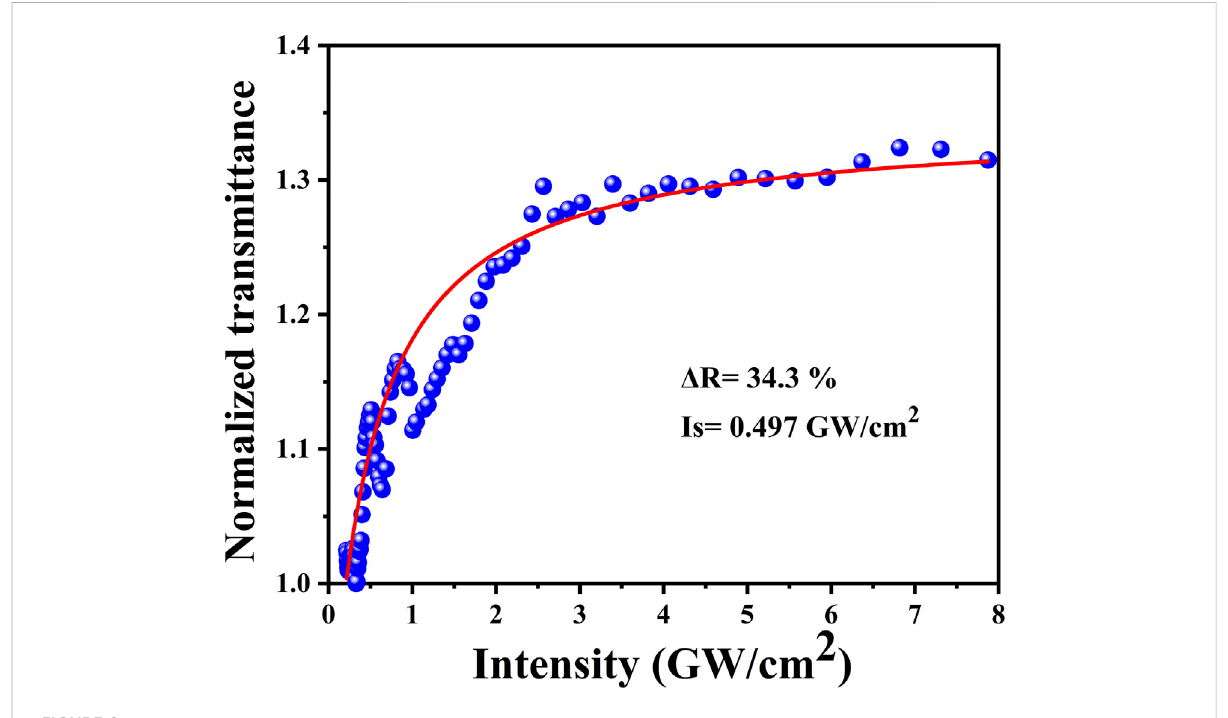
The normalized nonlinear transmittance versus the pump energy